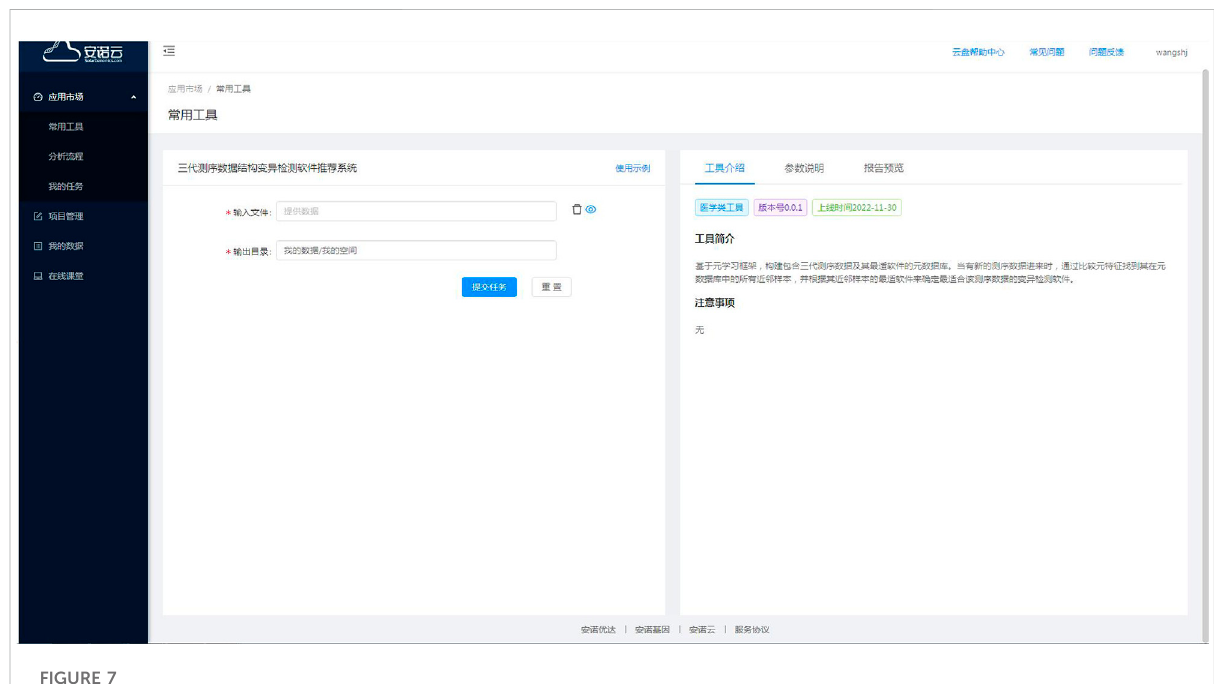
FIGURE 7 The online recommendation tool input page.